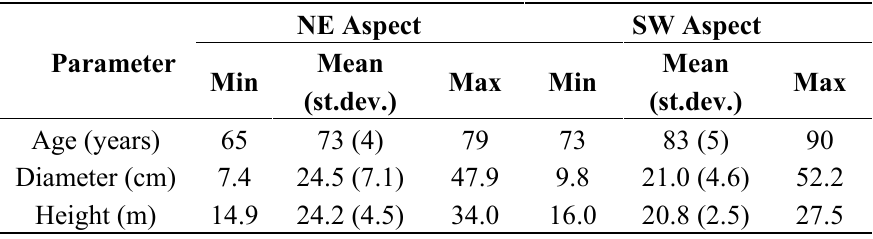
Table 3. Tree parameters in 1999 before